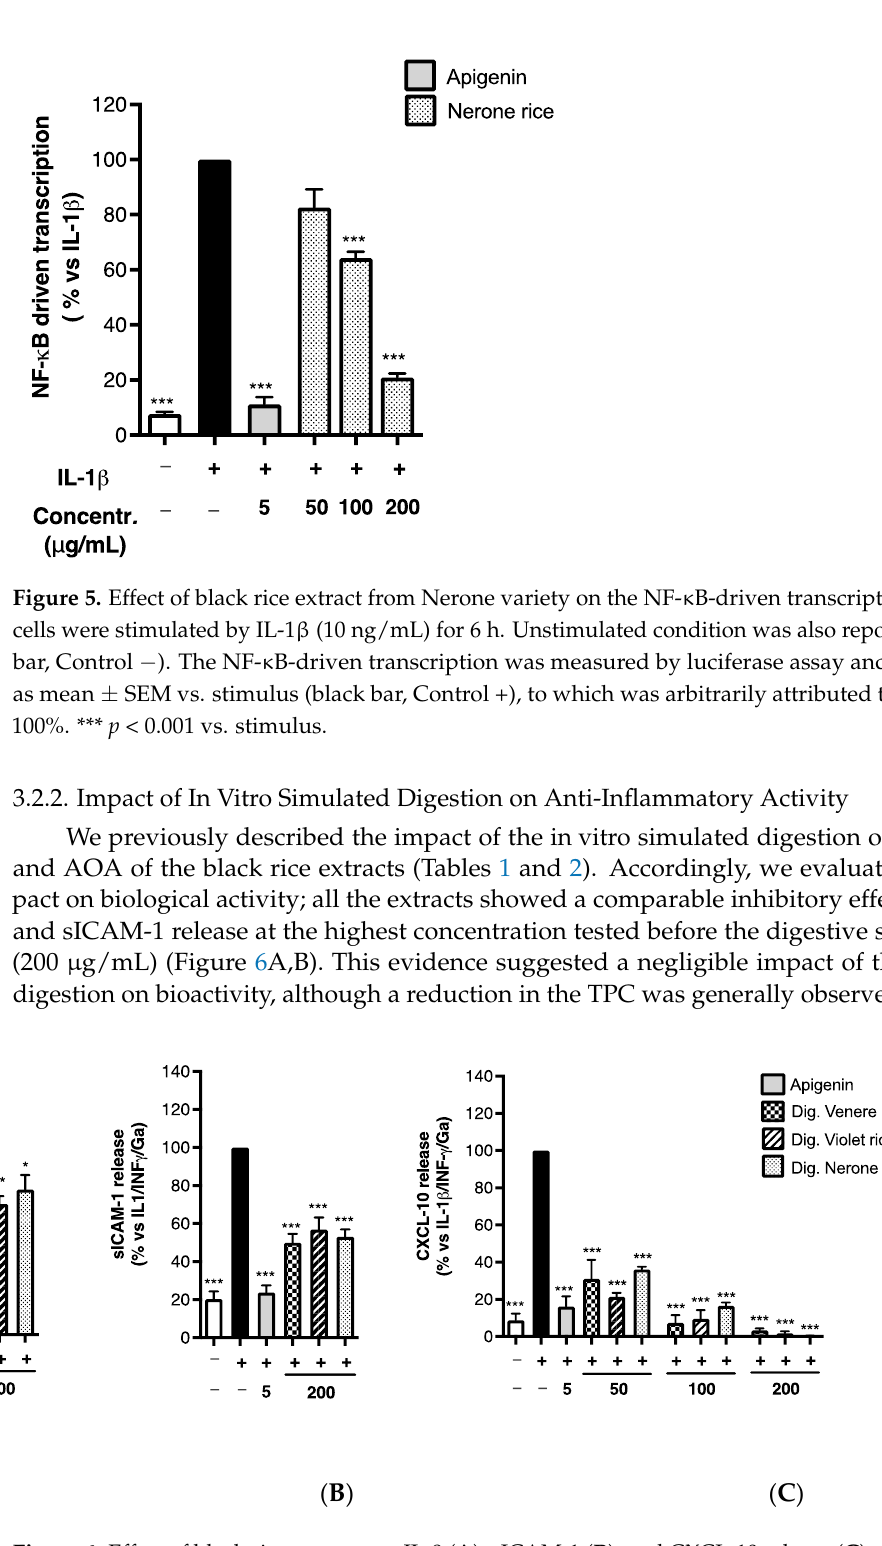
( B ) Figure 7. Effect of black rice extract from Nerone variety on NF- κB -driven transcription after in vitro simulated digestion. Caco-2 cells were stimulated by IL- 1β (10 ng/mL) for 6 h. Unstimulated condi- tion was also reported (white bar, Control − ) ( A ). The NF- κB -driven transcription was measured by luciferase assay and expressed as mean emission ± SEM vs. stimulus (black bar, Control +), to which was arbitrarily attributed the value of 100% ( B ). * p < 0.05, *** p < 0.001 vs. stimulus.